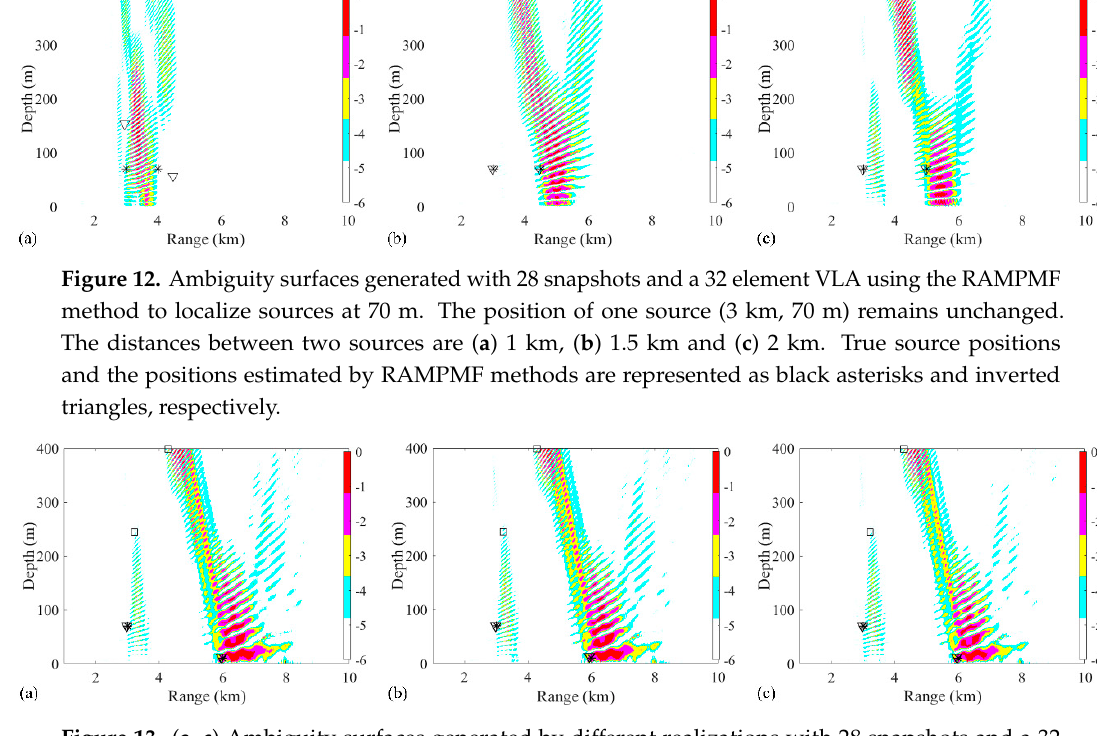
Figure 12. Ambiguity surfaces generated with 28 snapshots and a 32 element VLA using the RAMPMF method to localize sources at 70 m. The position of one source (3 km, 70 m) remains unchanged. The distances between two sources are ( a ) 1 km, ( b ) 1.5 km and ( c ) 2 km. True source positions and the positions estimated by RAMPMF methods are represented as black asterisks and inverted triangles, respectively.